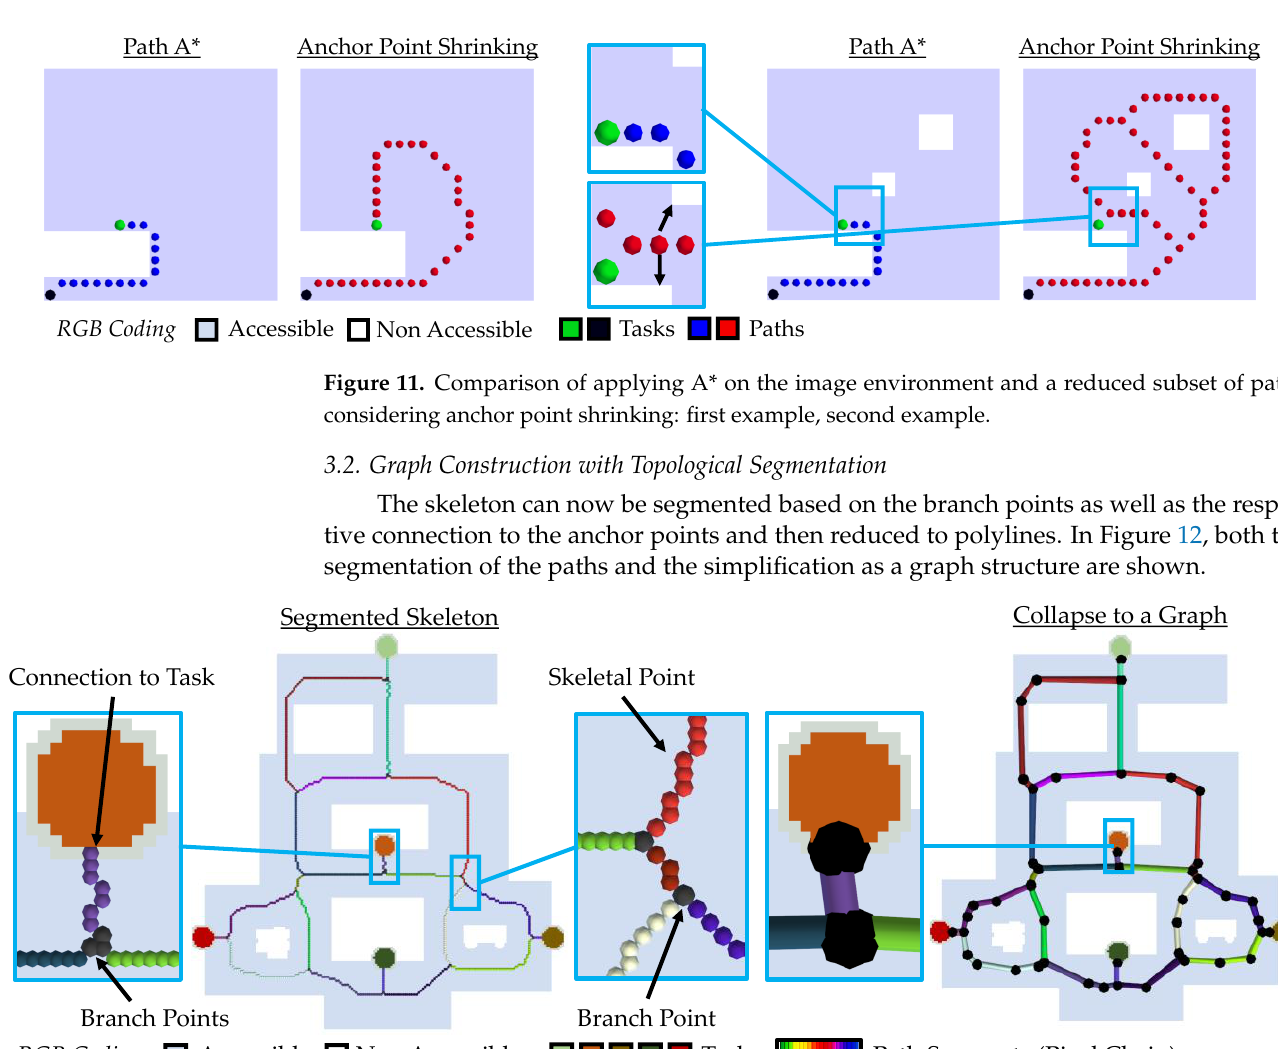
Figure 11. Comparison of applying A* on the image environment and a reduced subset of paths considering anchor point shrinking: first example, second example.